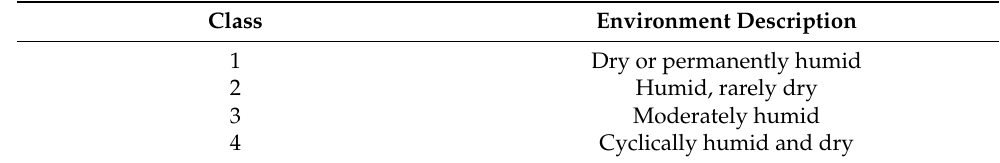
Table 1. Classes for carbonation-induced corrosion according to EN206-1 [6]. Class Environment